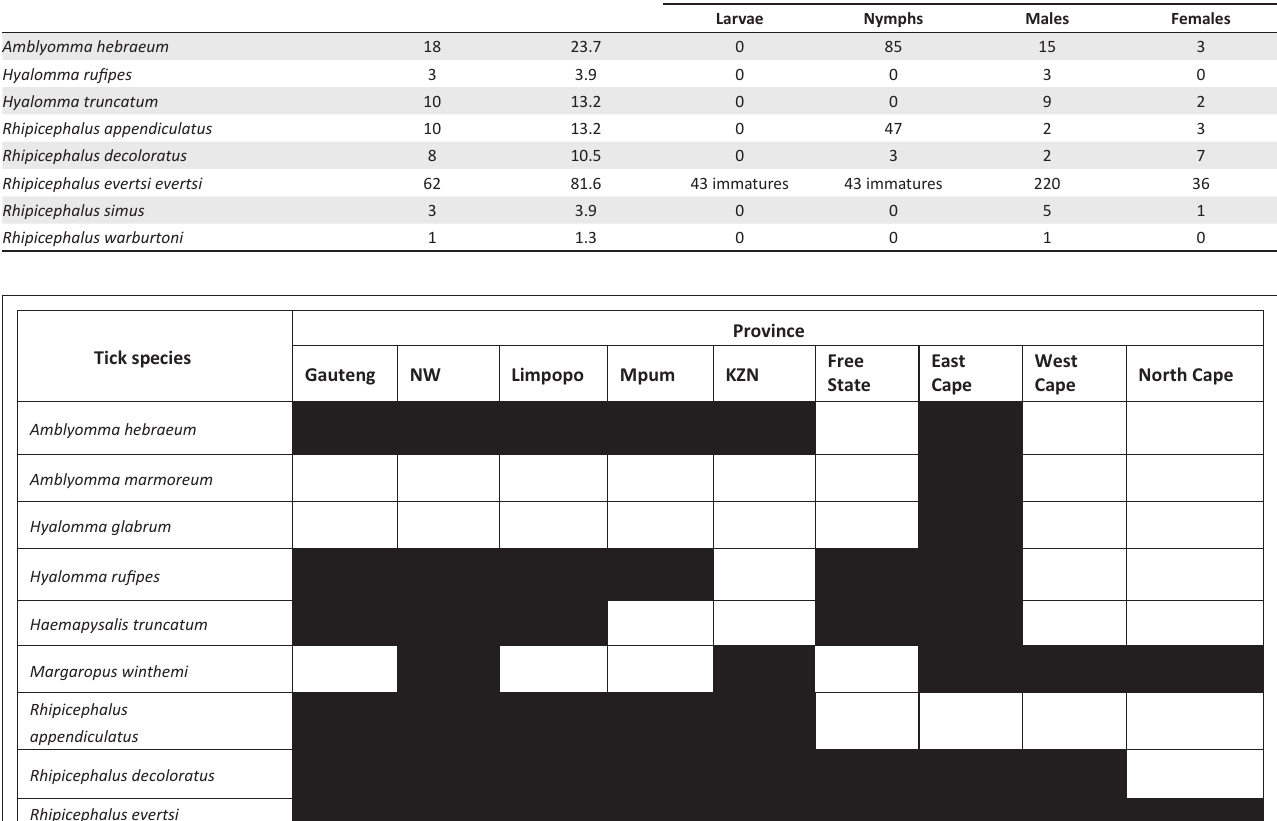
TABLE 2: Ixodid ticks collected from 76 donkeys, mostly in Limpopo Province. Tick